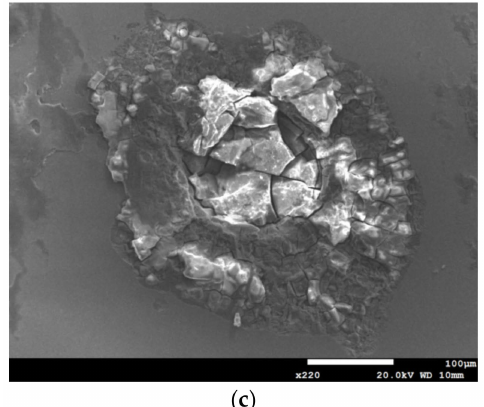
Figure 5. SEM morphologies of corrosion products after 5000 h tests with 1 g / m 2 chloride concentration. ( a ) RH = 45%, ( b ) RH = 55%, and ( c ) RH = 70%.